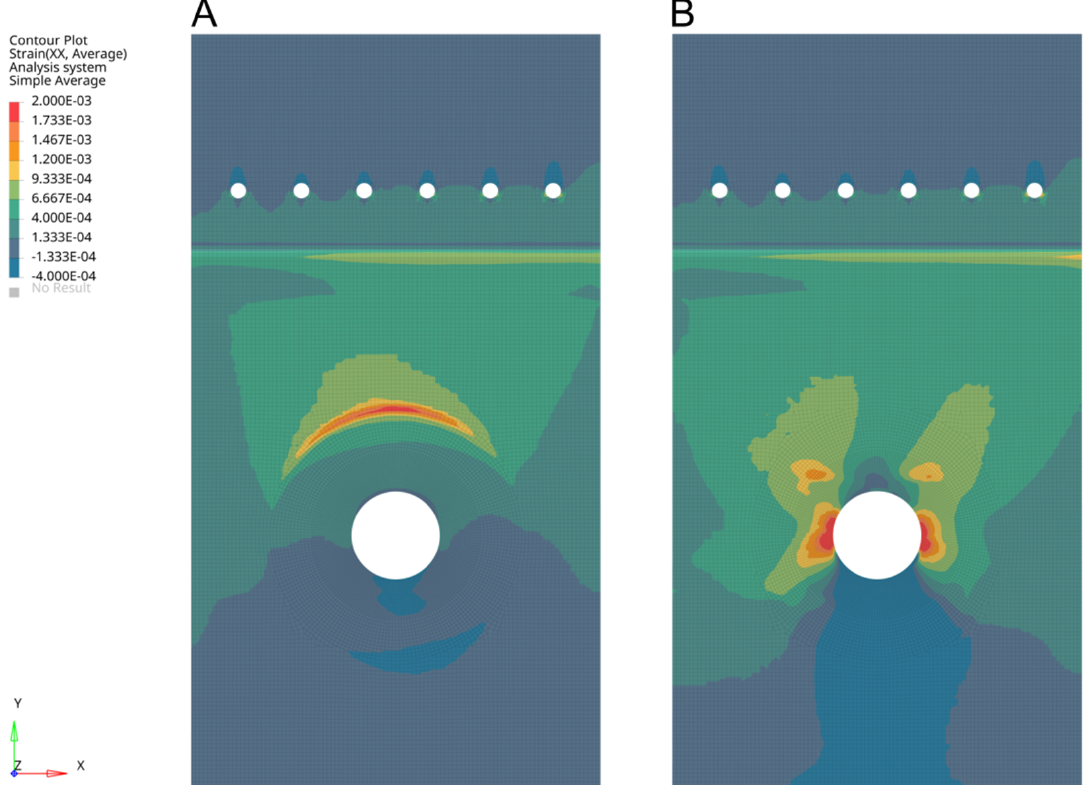
Figure 14. An external qualitative view of the longitudinal strain distribution of the advanced and simple joint ( A ) first-ply longitudinal strain of the advanced composite face under 20 kN ( B ) first-ply longitudinal strain of the simple composite face under 20 kN.